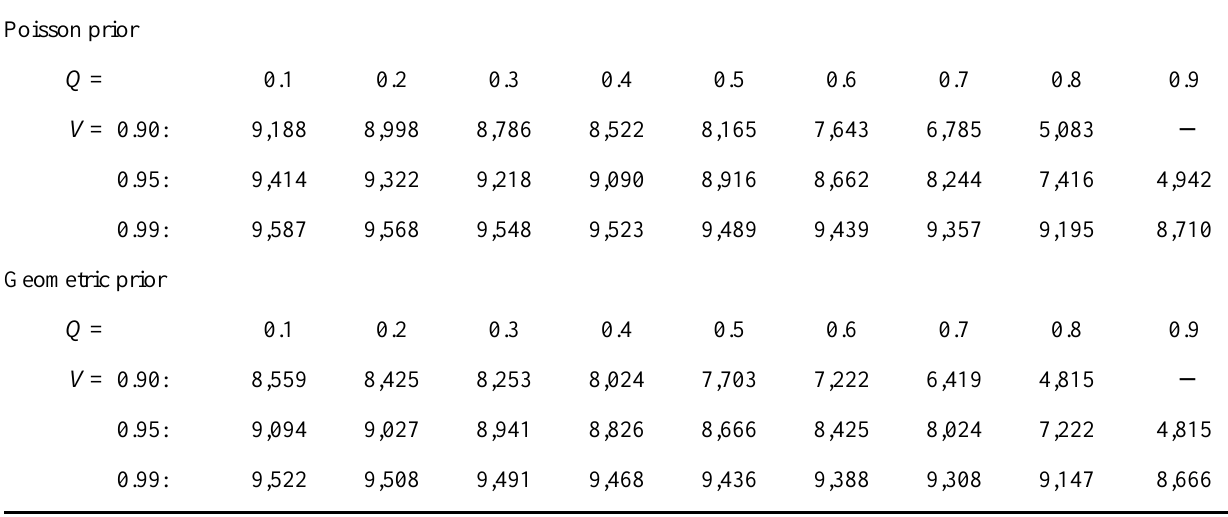
Table 4. Sampling effort (number of variable circular plot (VCP) stations) required for three levels of statistical confidence of extinction (i.e., desired posterior probabilities) (V) across a range of prior probabilities of extinction (Q) for two prior probability